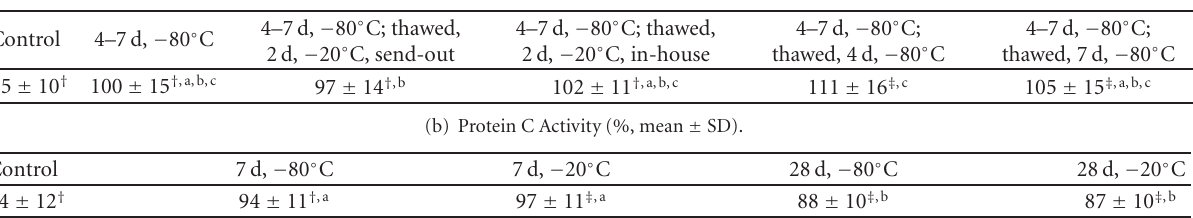
Table 3: Protein C activity results of fresh (control) and stored plasma for Phase 1 (a) and Phase 2 (b). Cross symbols indicate results of comparisonsof control and treatment groups, and alphabetical symbols indicate results of comparisonsof di ff erent treatment groups; results for groups including the same symbols are not significantly di ff